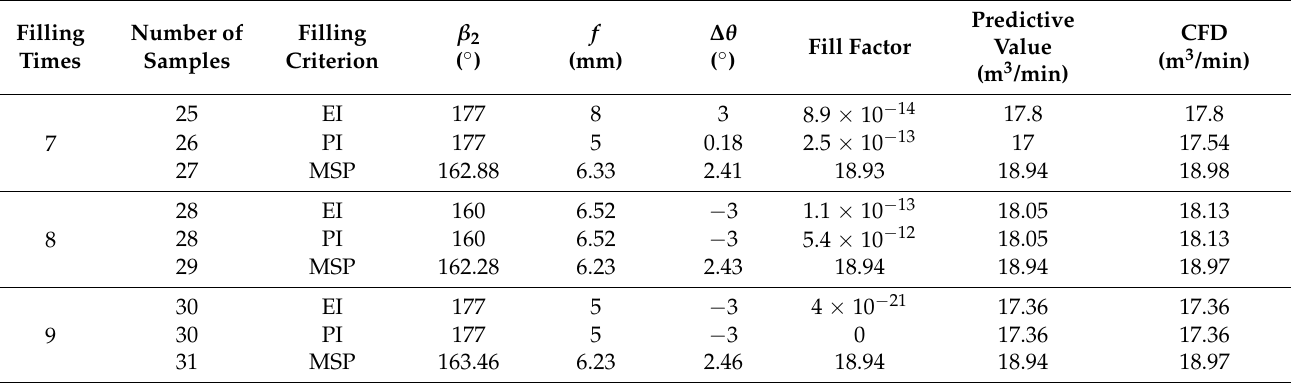
Table 6. Filling process in the improvement stage.